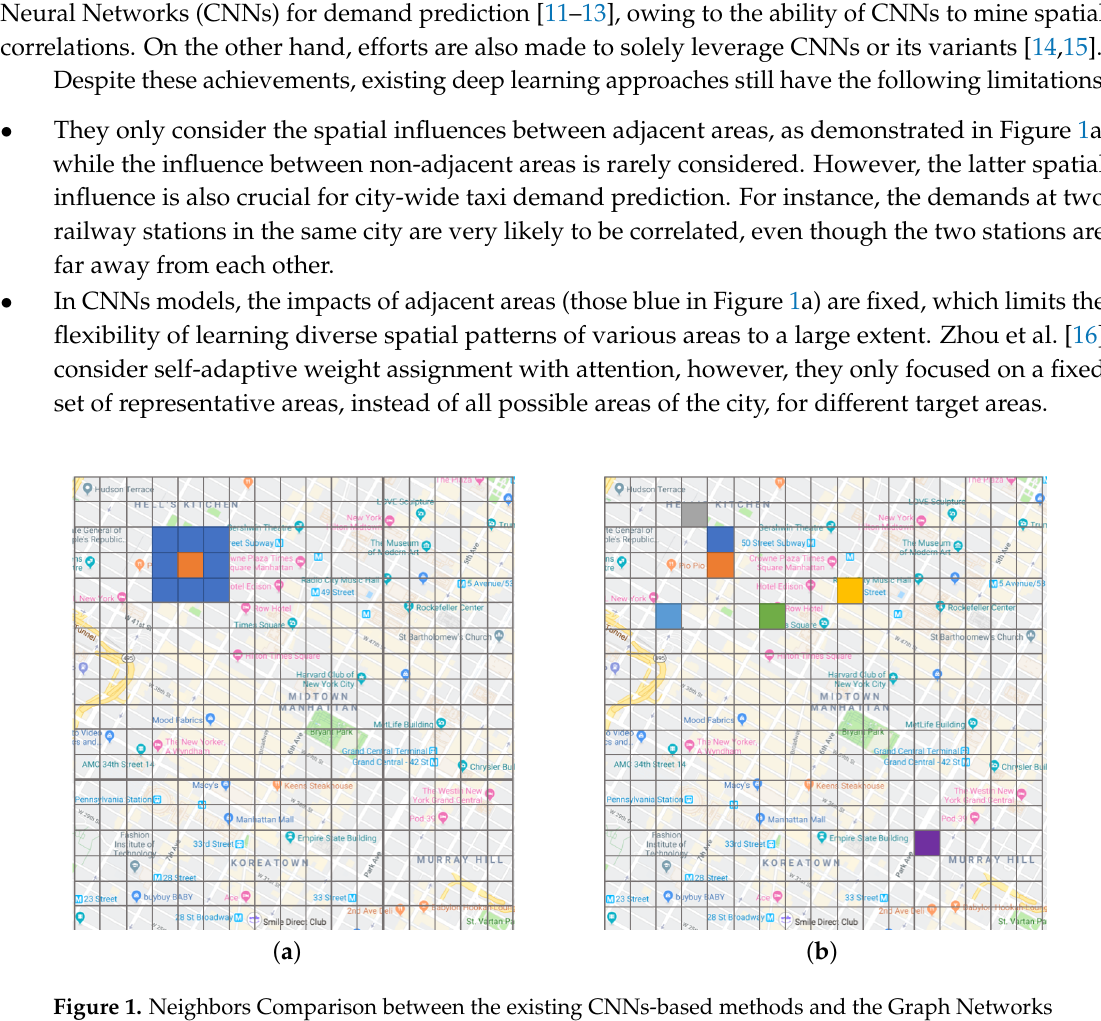
Figure 1. Neighbors Comparison between the existing CNNs-based methods and the Graph Networks based method used in our work. ( a ) The center grid (the orange one) and its neighboring grid cells (blue ones) in the previous CNNs-based methods. The city is regarded as an image. In this image, all neighboring grid cells are adjacent to the center grid and transfer the same influence to the center grid. ( b ) The center grid (orange one) and its neighbor grids (other colored ones) in our approach. We consider the city as a graph and each grid as a node. The neighbors in the graph may not be adjacent to the center grid in the physical world, and the neighbors could have different impacts on the center